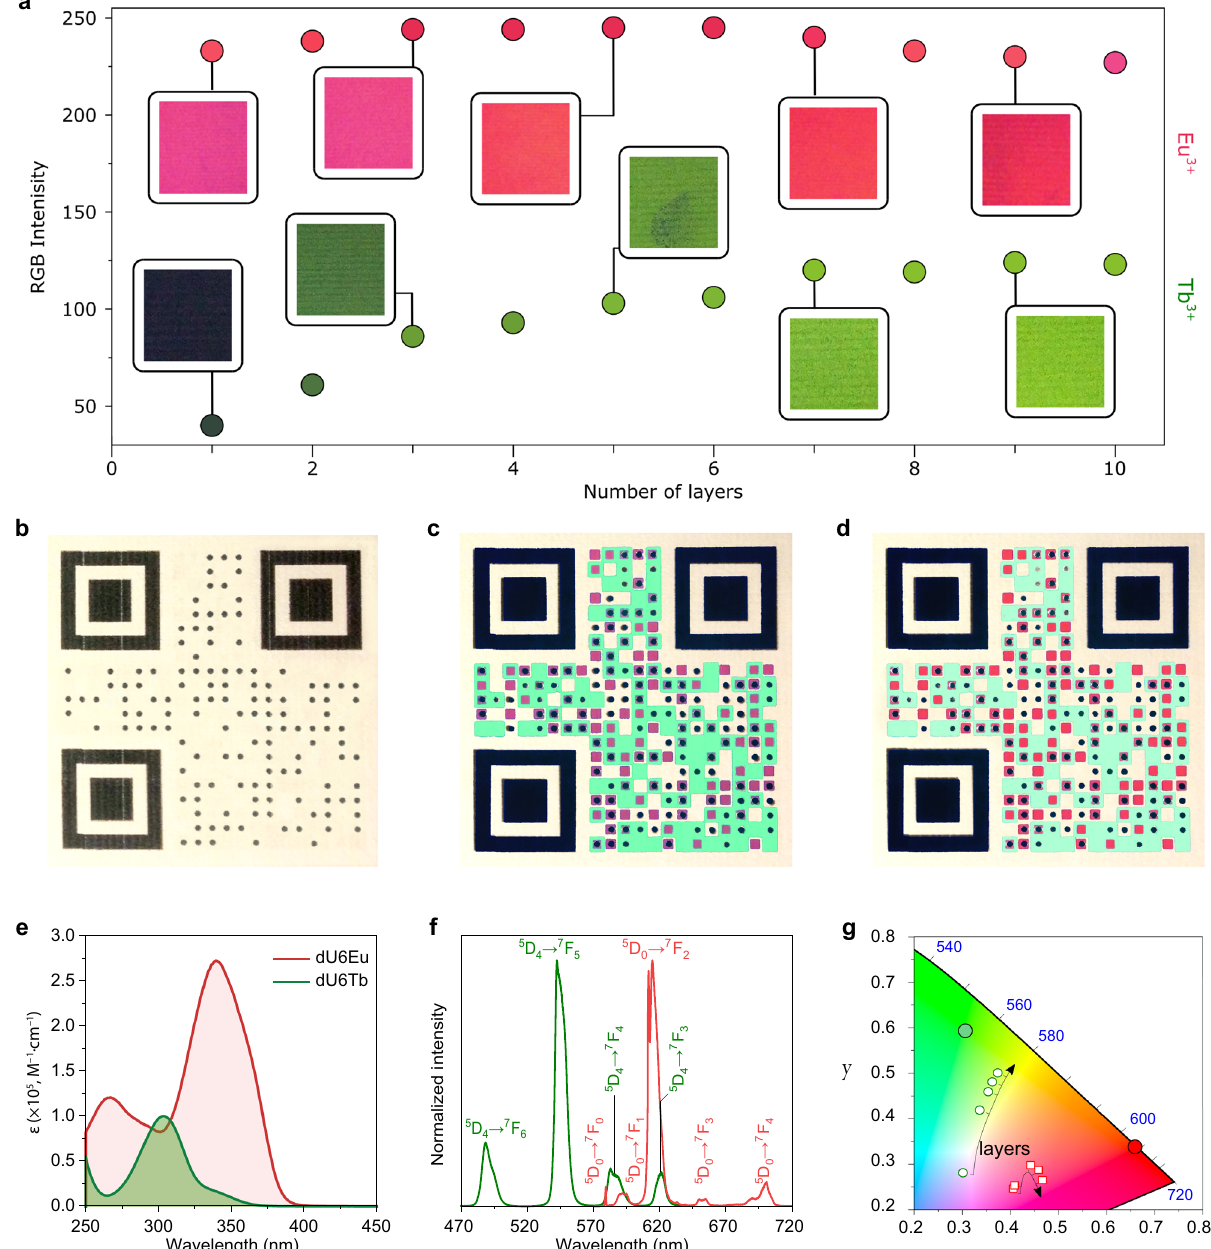
Fig. 2 Emission properties, printing and colour analyses. a Emitted intensity quanti fi ed by the RGB colour coordinates for dU6Tb as a function of the number of printouts under 254 nm excitation and for dU6Eu under 365 nm excitation. Images were obtained with a smartphone camera. The printed luminescent QR code images under b daylight excitation, c 254 nm excitation presenting an intense green colour and d 365 nm emitting a bright red colour. e Absorption extinction coef fi cient and f emission spectra excited at 350 and 370 nm for dU6Tb and dU6Eu, respectively. g CIE diagram with the colour coordinates for dU6Eu and dU6Tb calculated from the emission spectra and with the colour coordinates for the images in ( a ) calculated from their RGB colour